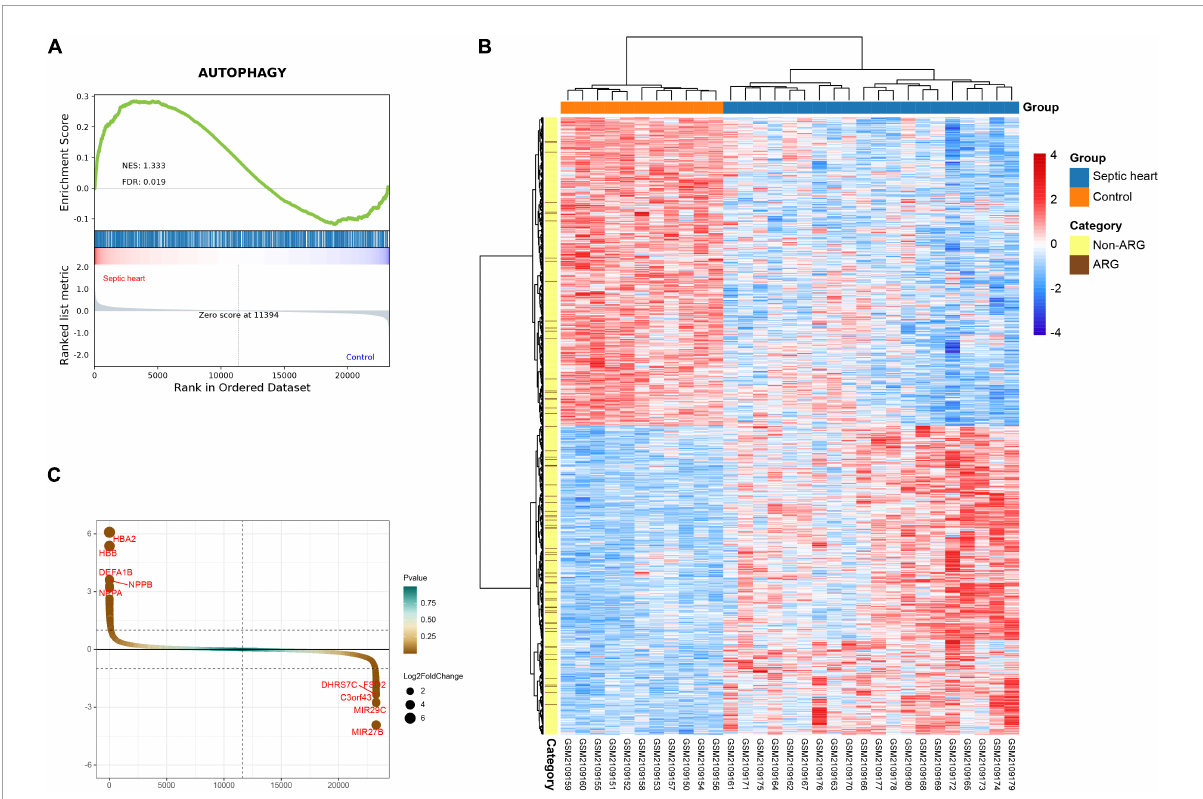
FIGURE2 (A) Gene set enrichment analysis (GSEA) and identification of differentially expressed genes. GSEA on ARG set in GSE79962. (B) Clustered heatmap of DEGs in GSE79962 (FDR < 0.05 and |log2FC| ≥ 0.5). (C) Volcano plot of DEGs in GSE79962 (FDR < 0.05 and |log2FC| ≥ 0.5). ARG, autophagy-related gene; DEG, differentially expressed